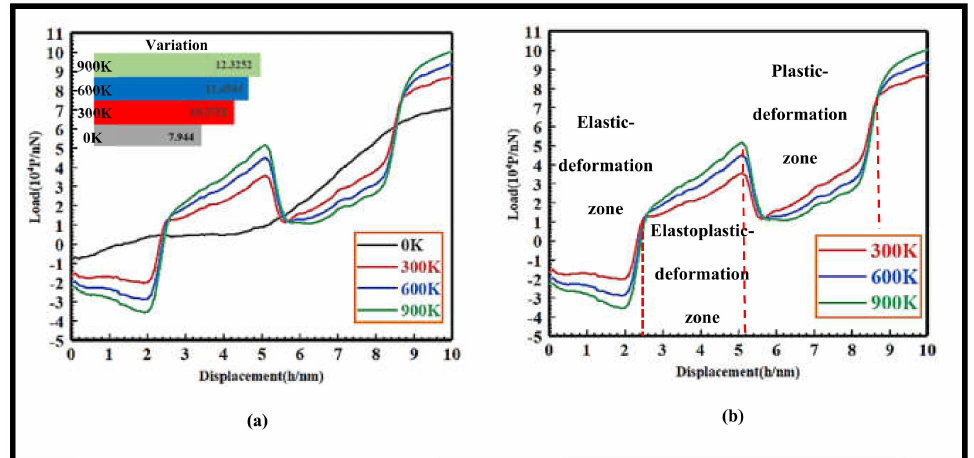
Figure 7. Comparison of load-displacement curves at different temperatures. ( a ) Low, normal, medium and high temperature load displacement curve, ( b ) Normal, medium and high temperature load displacement